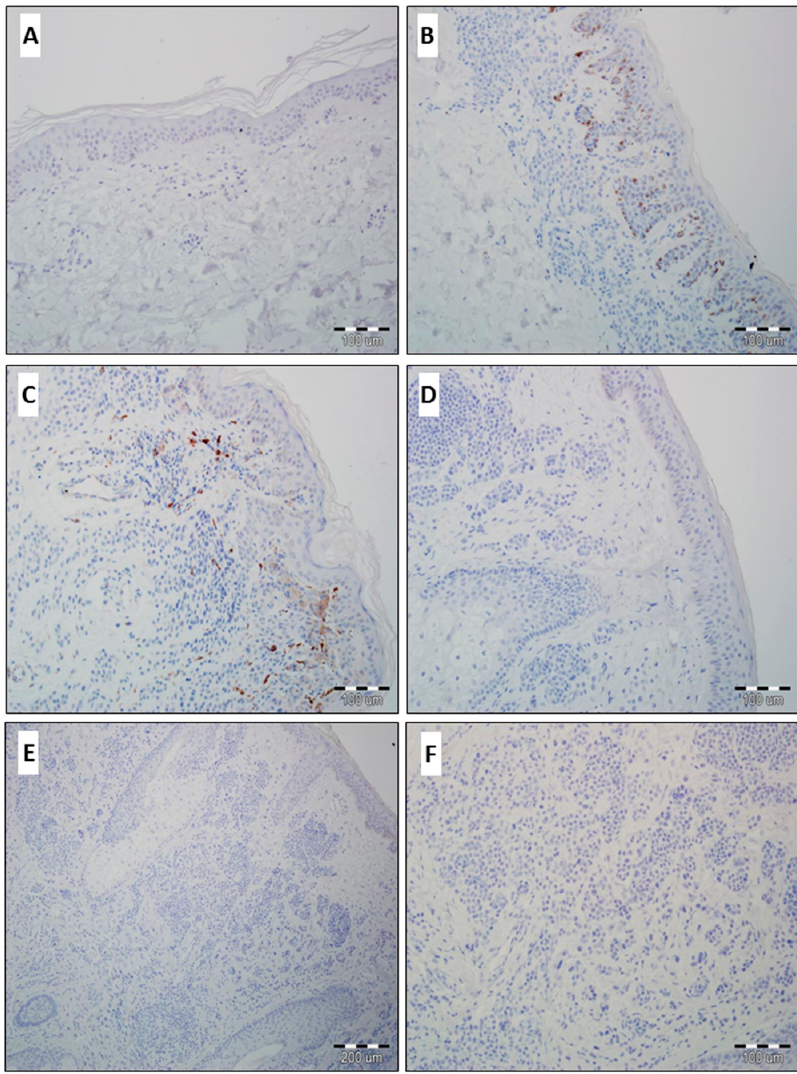
Figure 1. Normal skin without GOLPH3 immunoreactivity (( A ) 200×, hematoxylin); Scanty expression of GOLPH2 in a compound skin nevus (( B ) 200×, hematoxylin); Scanty expression of GOLPH3 in a compound skin nevus (( C ) focal and low GOLPH3 reactivity in benign melanocytes and a small percentage of GOLPH3-positive stromal cells; 200×, hematoxylin); Lack of GOLPH2 expression in an intradermal nevus (( D ) 200×, hematoxylin); Lack of GOLPH3 expression in an intradermal nevus (( E ), 100×; ( F ), 200×, hematoxylin).